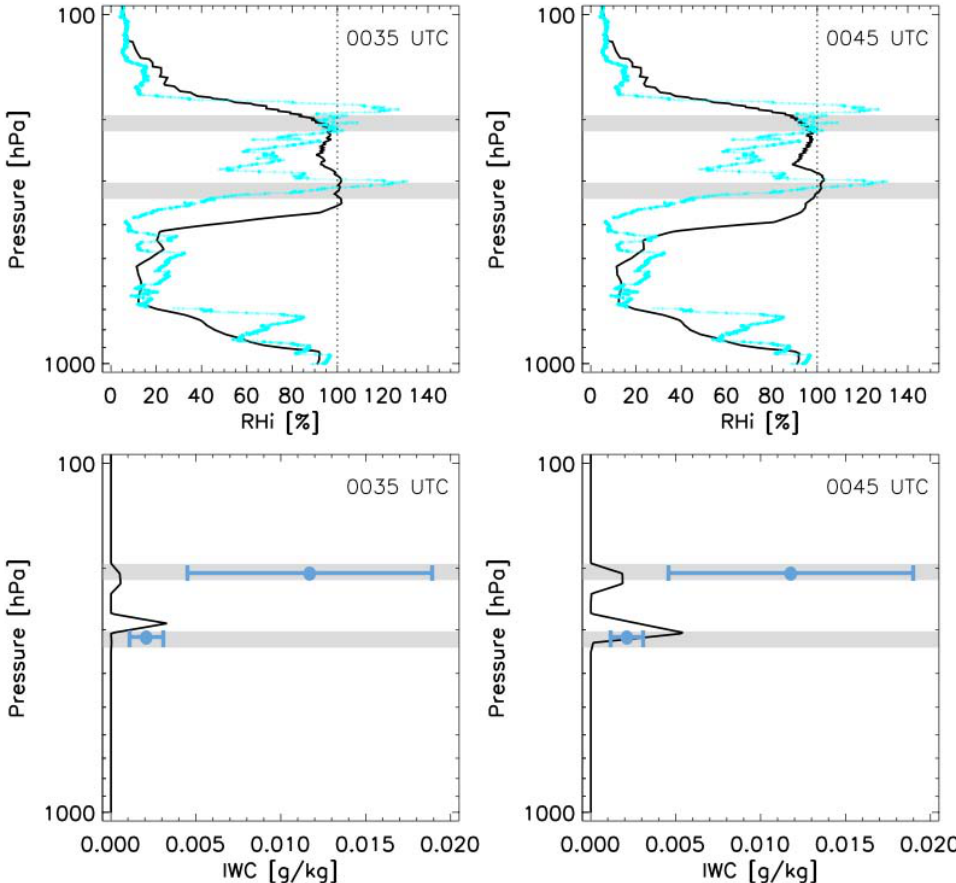
Fig. 2. RH ice and IWC profiles of COSMO-7 forecast data (black lines) above Lindenberg on 6 November 2008. Left: sounding of lower cloud at 00:35UTC. Right: sounding of upper cloud at 00:45UTC. Cyan line: RH ice profile measured by CFH. Grey horizontal bars: altitude ranges of the detected clouds. Blue bars in the lower two panels: IWC estimated from COBALD data as explained in Appendix A.